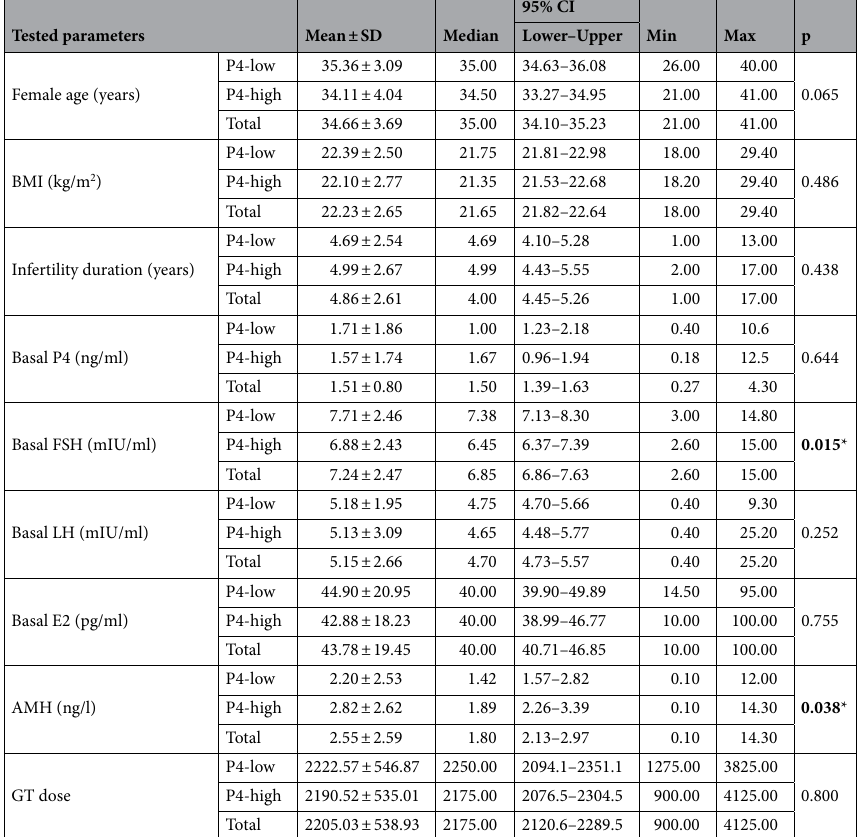
Table 1. Patients’ characteristics and basal hormonal levels regarding P4 levels on the day of OR. BMI body mass index, FSH follicle stimulating hormone, LH luteinizing hormone, E2 estradiol, P4 progesterone, AMH anti-Mullerian hormone, GT gonadotropins, ART assisted reproduction technologies. *p <